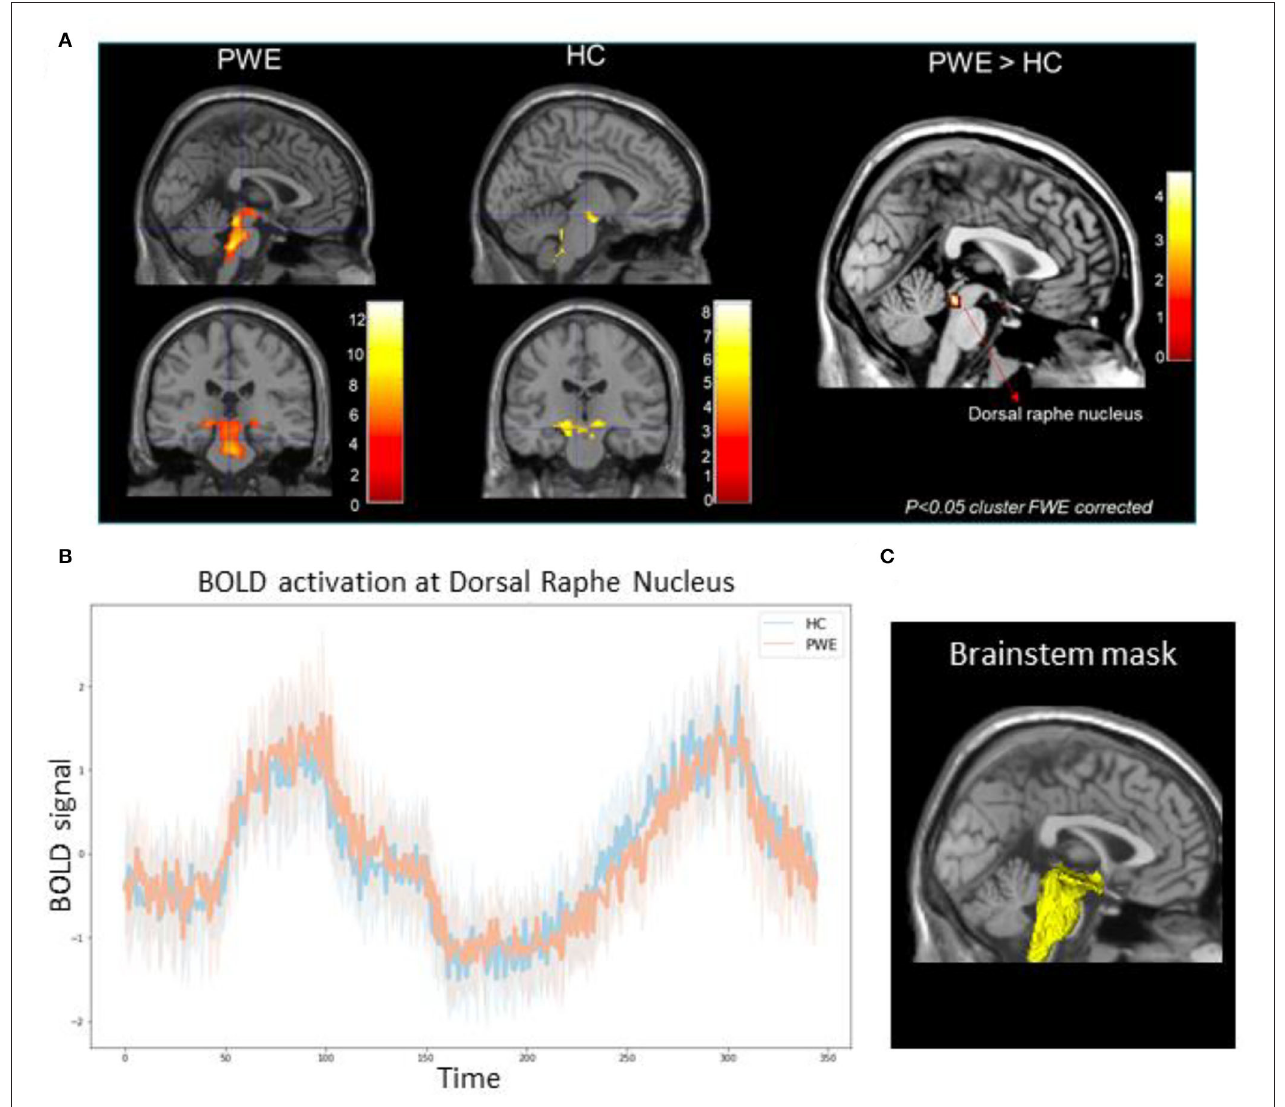
FIGURE 1 | (A) Group-level brainstem BOLD activation differences among 10 patients (PWE) and 10 healthy controls (HC) during CO 2 challenge showed greater activations among PWE at the dorsal raphe nucleus (p FWE < 0.05) compared to HCs. Color bars represent Z-score activation values. (B) Line plot represents mean BOLD activation time series extraction from all PWE (orange) and HCs (blue) at the dorsal raphe nucleus in response to the step and ramp challenge. Shaded hue areas represent corresponding individual confidence intervals. (C) 3D reconstruction of the explicit brainstem plus binary mask (yellow) used in the analysis overlaid over standard template T1